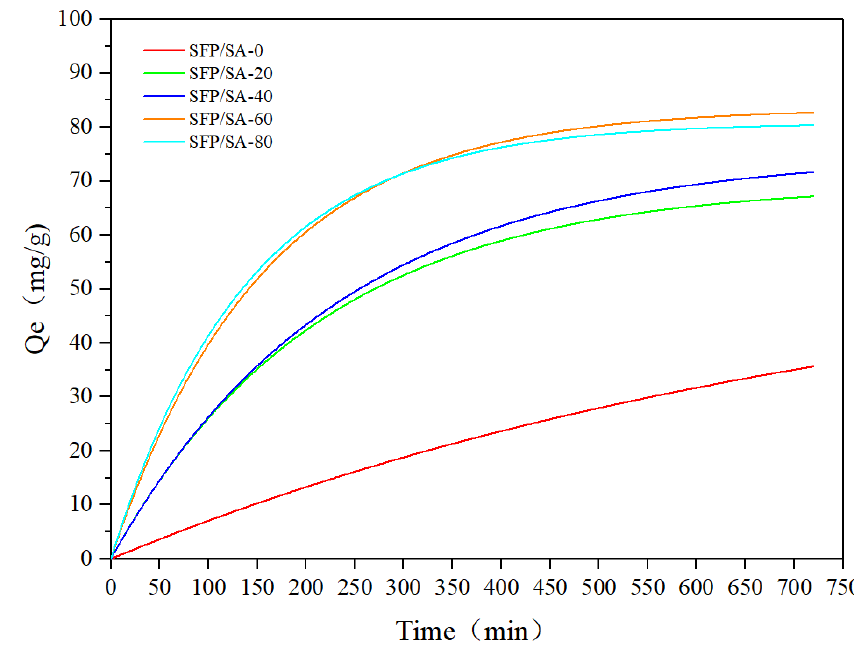
Figure 6. Effect of contact time of SFP/SA on adsorption capacity of CV. (SFP/SA: 25 mg, swelling treatment for 24 h. CV: 25 mL, pH = 7.0, 100 mg/L).